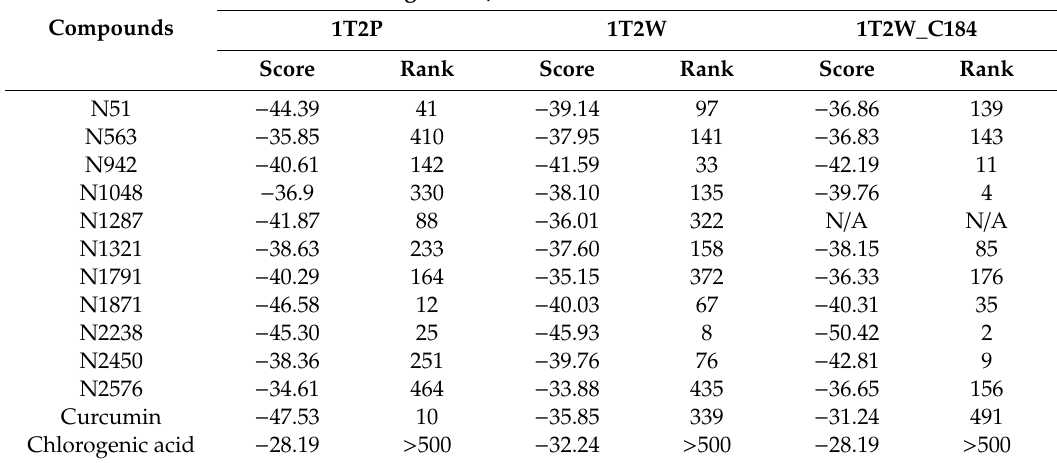
Table 1. Summary of the eleven natural products picked for experimental validation, comparing to curcumin and chlorogenic acid.